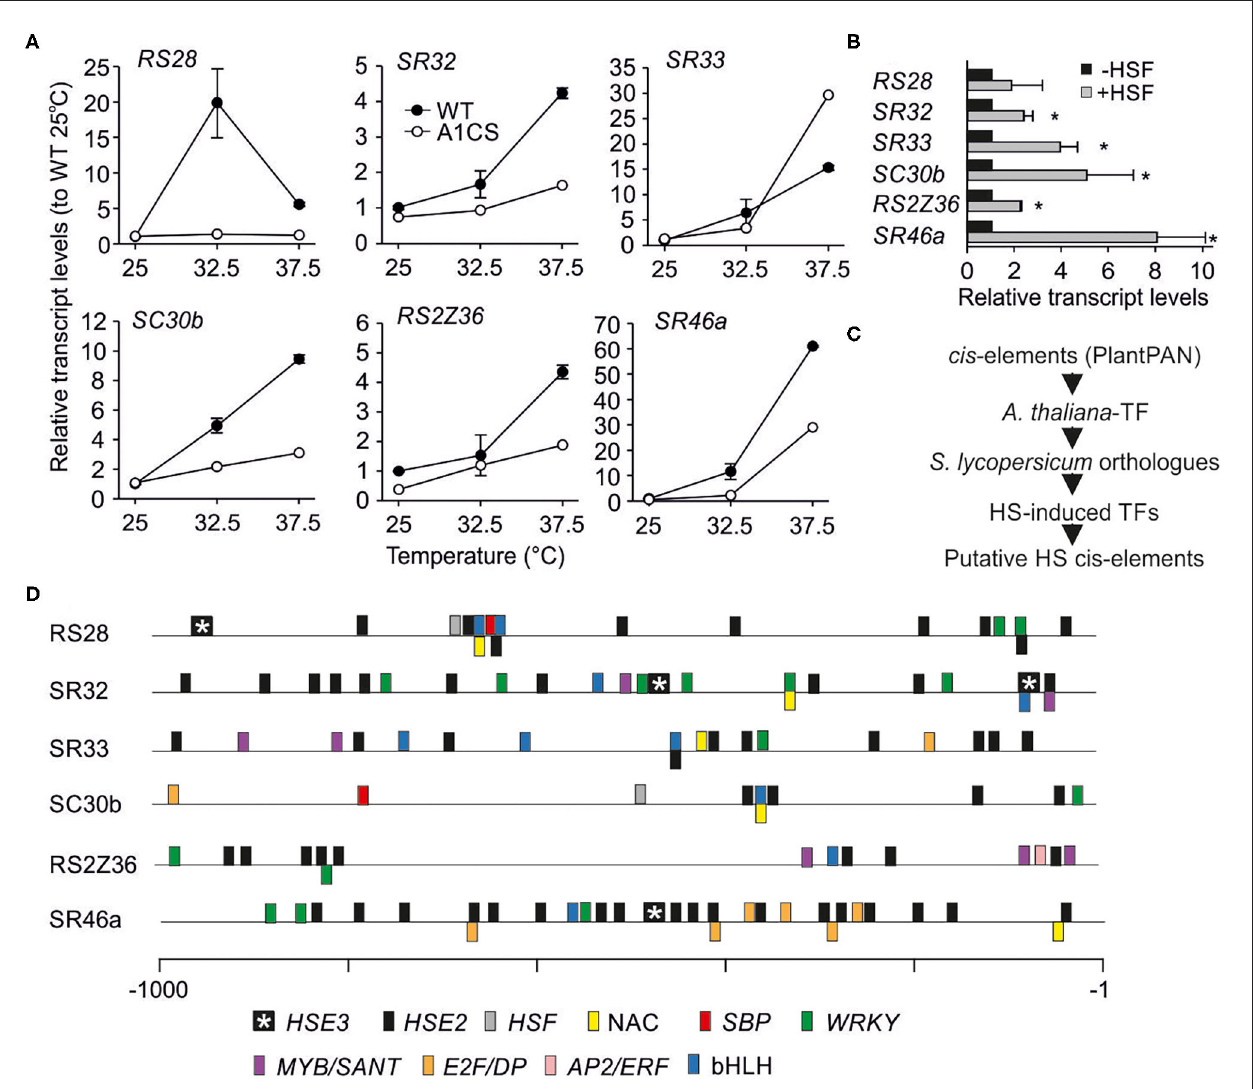
FIGURE 7 | Regulation of selected SR genes under heat stress. (A) Total transcript levels of the indicated SR coding genes in wild type and A1CS young leaves exposed to 25, 32.5 or 37.5 ◦ C for 1h. Relative levels were calculated as in Figure 6B . (B) Relative levels of total transcripts of the indicated endogenous SR genes in protoplasts co-expressing HsfA1a and HsfA2 ( + HSF). Relative levels were calculated as in (A) using mock protoplasts (–HSF) as control sample. Each value is the average of 3 independent replicates and error bars indicate ± SE. Asterisks indicate significant difference ( p < 0.05) compared to control based on pairwise t -test. (C) Workflow for the identification of cis -elements in SRs genes. (D) The relative position of the cis -elements identified in the promoter region of 1,000 bp upstream of the initiation codon for each of the indicated genes ( Supplementary Dataset 4 ). The elements are denoted in color code. HSE2 and HSE3 are composed of two or three palindromic nGANn or nGNAn